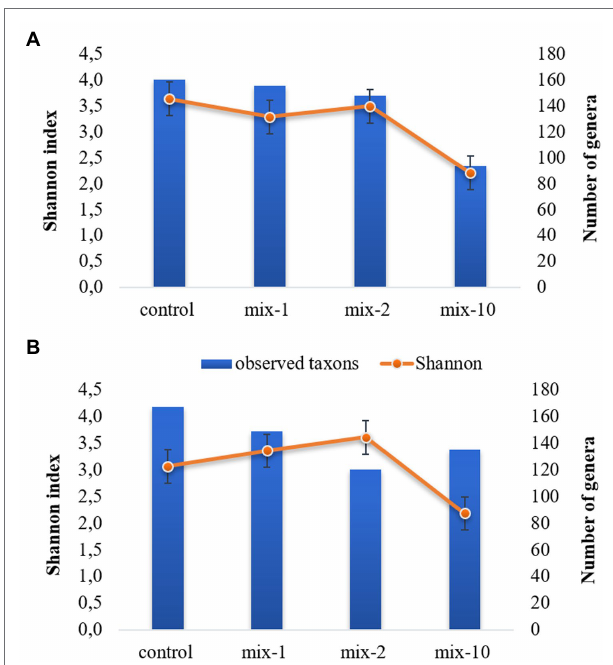
FIGURE 5 | Dynamics of Shannon index and number of genera on day 7 (A) and day 14 (B) of incubation (mean ± SE). 1/2/10 is the recommended, 2-fold and 10-fold pesticide application